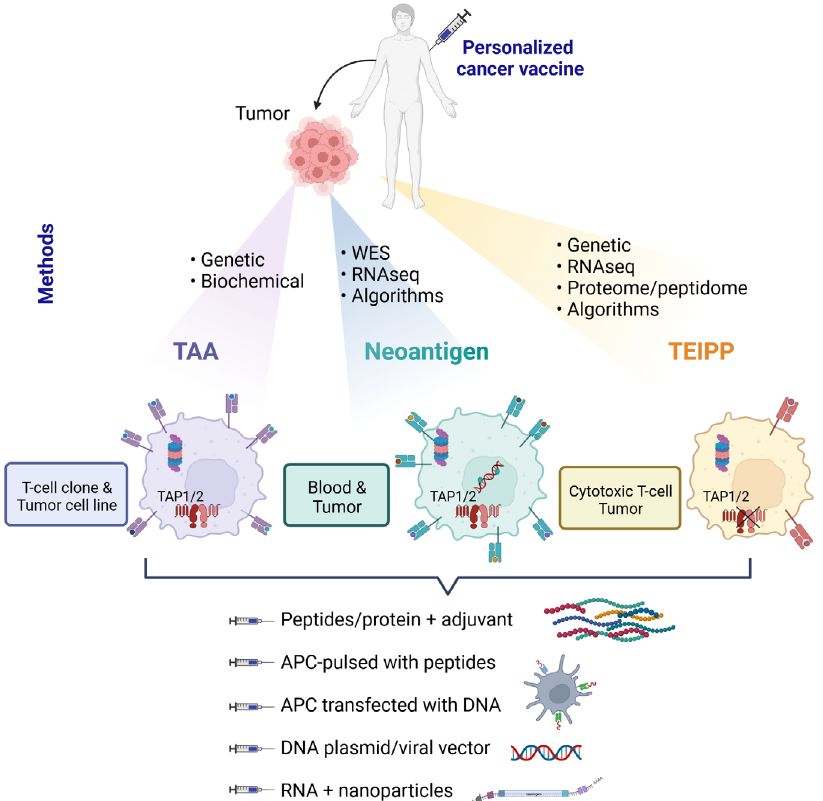
Figure 1. Therapeutic cancer vaccines based on shared TAA, mutant neoantigens, and non-mutant neoantigens, named TEIPP. Methods of identification and required biological materials are described and specified for each type of antigen. RNAseq: RNA sequencing; TAP1/2: transporter associated with antigen processing 1 and 2; APC: antigen-presenting cell; WES: whole exome